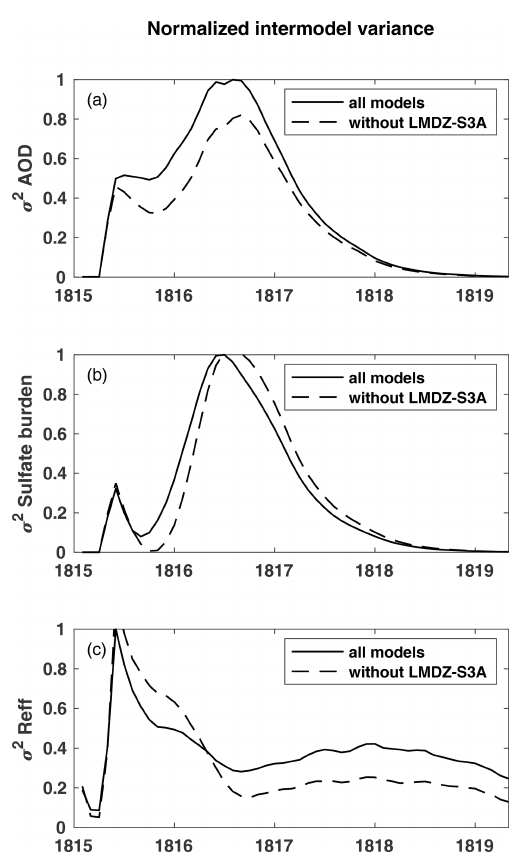
Figure 7. Variance between VolMIP-Tambora ISA ensemble mod- els for global mean stratospheric (a) AOD, (b) sulfate burden, and (c) effective radius. All models are included in the solid line. All models except for LMDZ-S3A are included in the dashed line. In both cases (solid and dashed lines), the plots have been normal- ized to the maximum value of the intermodel variance of all models (including LMDZ-S3A) at each corresponding variable. The peak values for the dashed line which are therefore slightly cut off from view by the y axis of the subplots for the sulfate burden and effective radius are (b) 1.03 and (c) 1.16. Sulfate burden and effective radius are two of the key output variables dominating the AOD equation, Eq. (1), which generate intermodel variance of